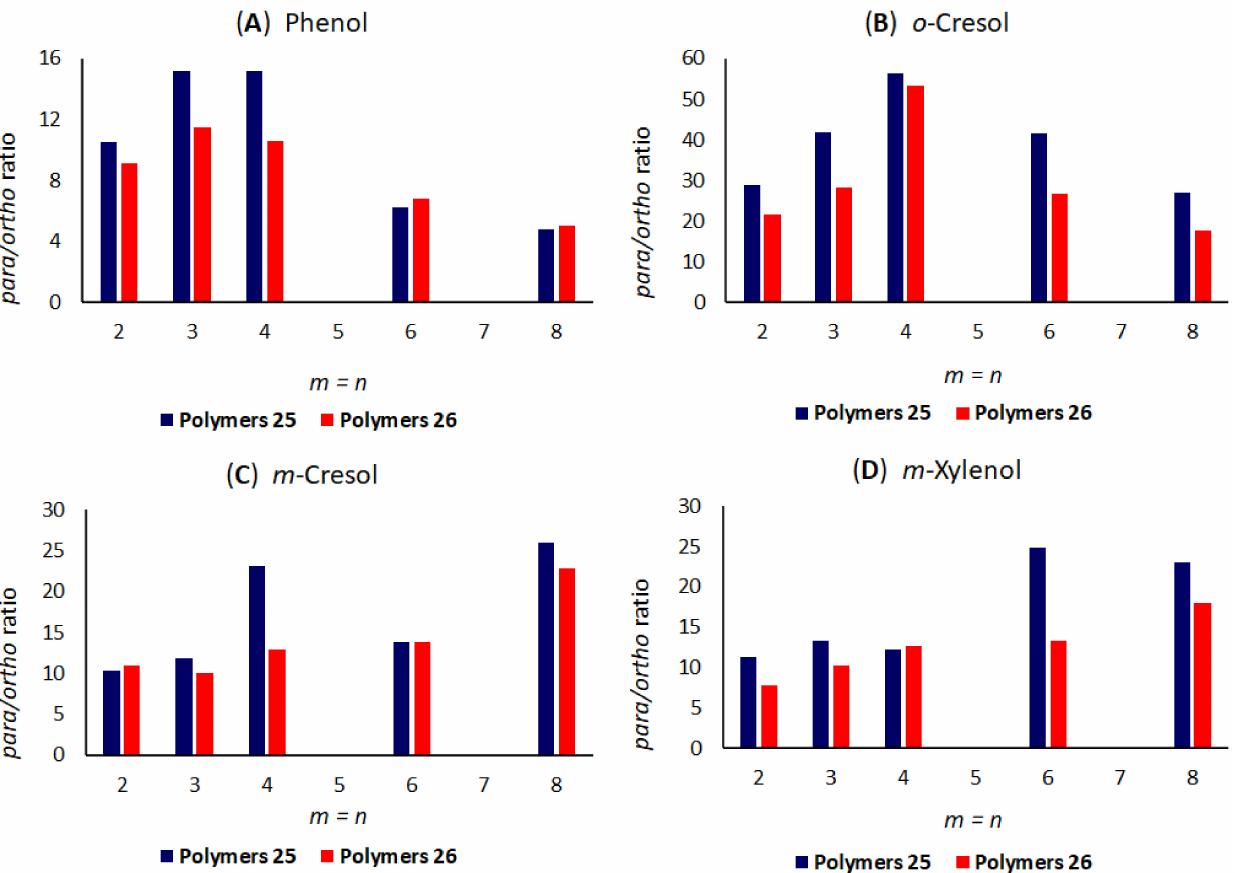
Figure 10. Effect of polymers 25 and 26 on the selectivity of chlorination of phenols according to Scheme 1. Conditions: For phenol (Chart A ): 100 mmol substrate, 110 mmol SO 2 Cl 2 , 100 mg AlCl 3 , 100 mg sulphur compound, 2 h addition of SO 2 Cl 2 then 2 h at room temperature. For o -cresol (Chart B ) and m -cresol (Chart C ): 100 mmol substrate, 110 mmol SO 2 Cl 2 , 500 mg AlCl 3 , 200 mg sulphur compound, 2 h addition of SO 2 Cl 2 then 2 h at room temperature. For m -xylenol (Chart D ): 100 mmol substrate, 110 mmol SO 2 Cl 2 , 100 mg FeCl 3 , 200 mg sulphur compound, 25 mL DCM, 2 h addition of SO 2 Cl 2 then 2 h at room temperature. b In the case of m- cresol, the ortho- product 2 is a mixture of 2-chloro-3-methylphenol (minor) and